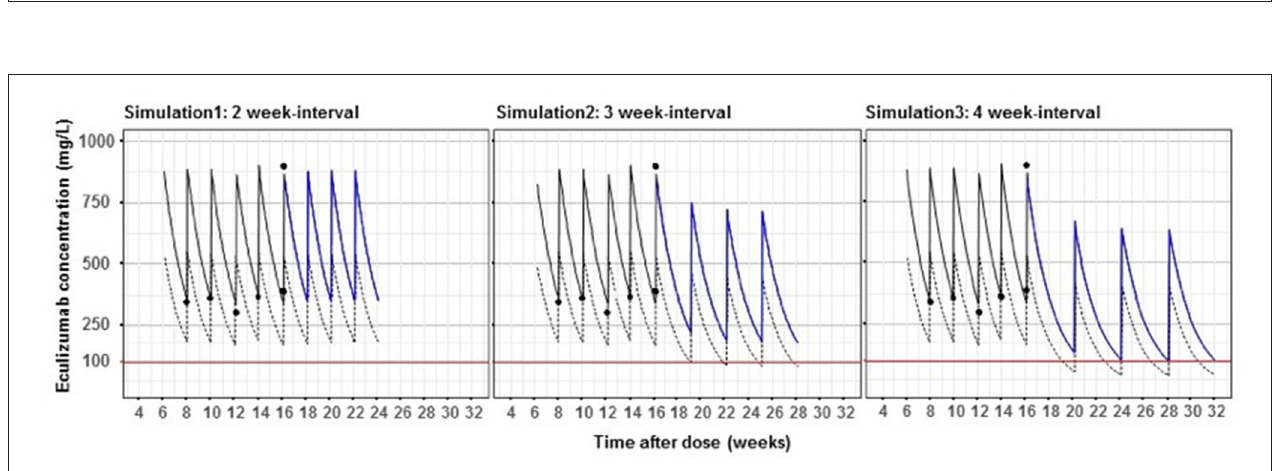
Frontiers in Pediatrics |